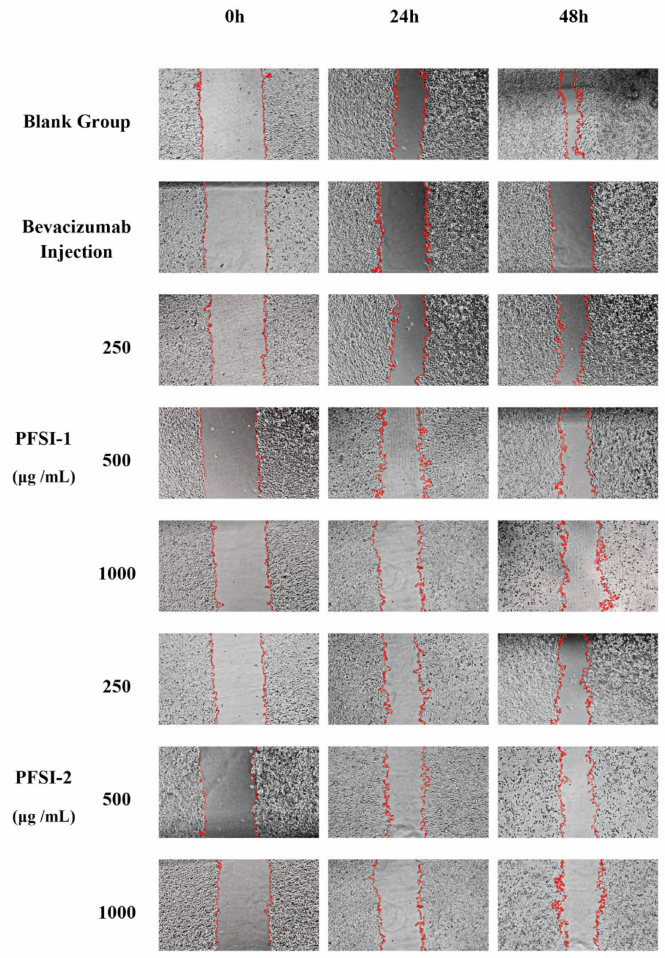
Figure 10. Scratching results of PFSI-1 and PFSI-2 on SMMC 7721 cells.